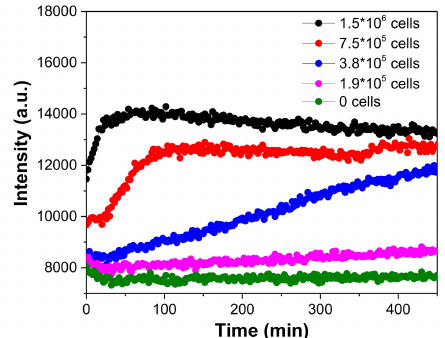
Figure 9. Oxygen consumptions of Romas cells at di ff erent cell densities in the emission model. Concentration of PtTFPP in medium for these measurements: 3 µ g / mL.